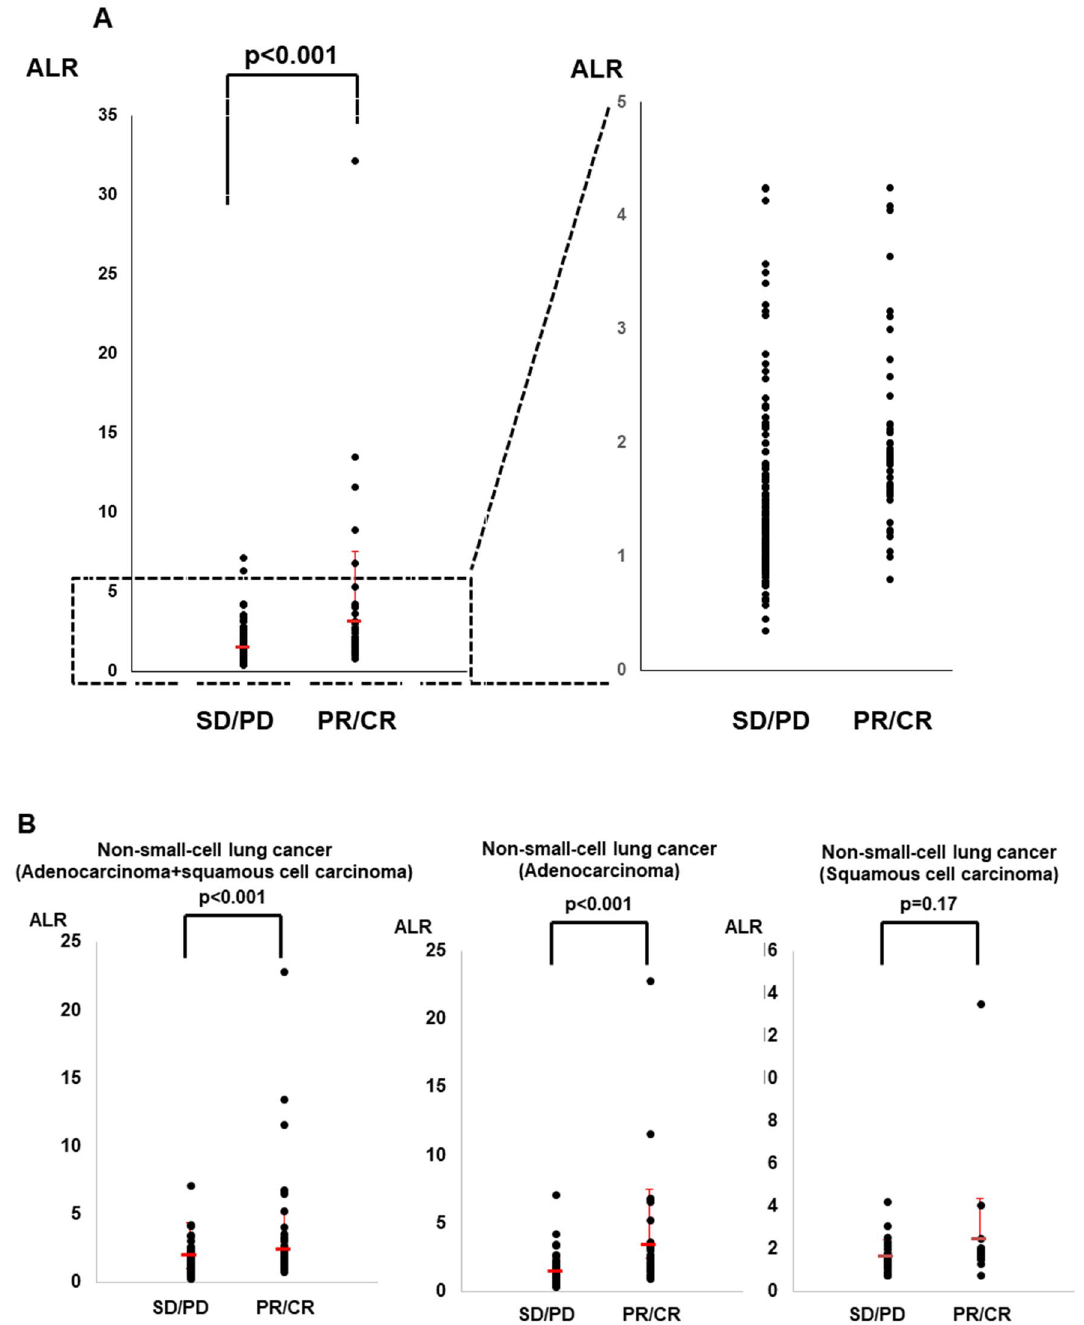
Figure 1. ( A ) ALR according to the response to immunotherapy (SD/PD, stable/progressive disease; PR/ CR, partial/complete response). ALR according to the response to immunotherapy against lung cancer ( B ), gastric cancer ( C ), renal cell carcinoma ( D ), and urothelial carcinoma ( E ). Bars represent the mean ALR. Error bars show the mean standard